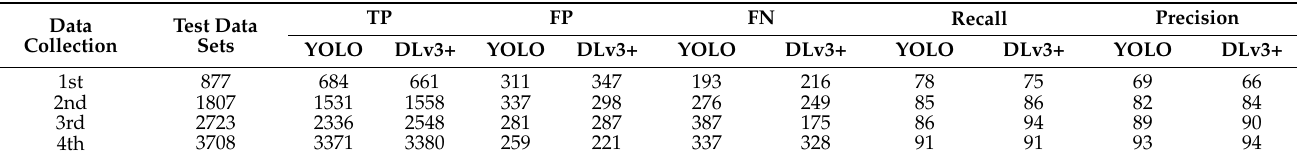
Table 6. Cultivated land search results for B1.